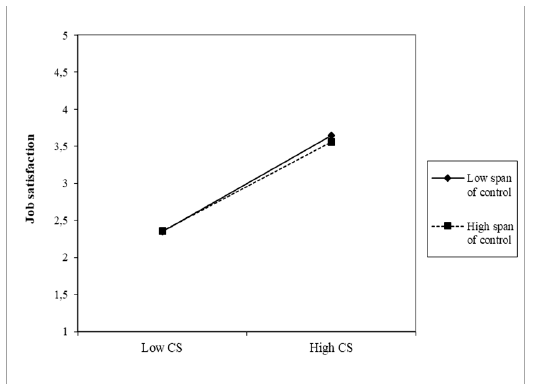
Figure 3. Moderating effect of practice in managing FLNMs on the TFL–JS relationship.